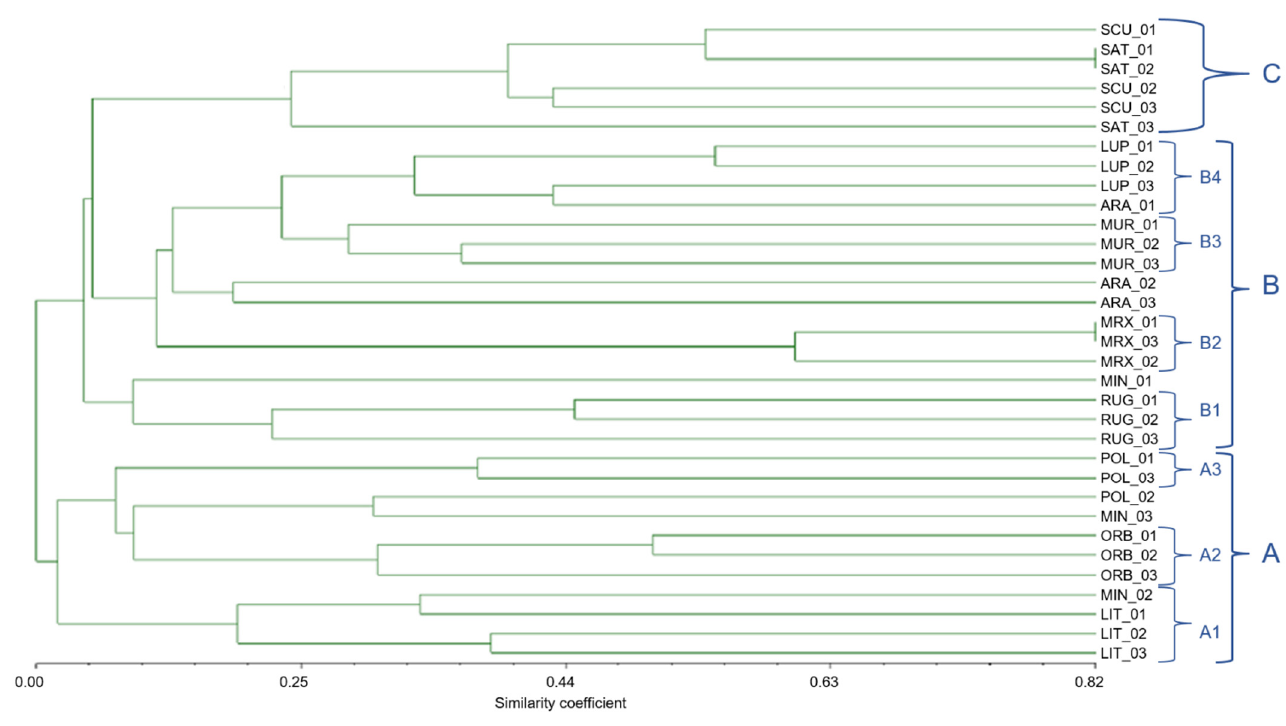
Figure 8. Dendrogram based on Jaccard similarity coefficients, computed from UPGMA, showing relatedness among the 11 Medicago species belonging to different sections. Clustering (A, B, and C) is based on both chloroplast and nuclear SSR markers.